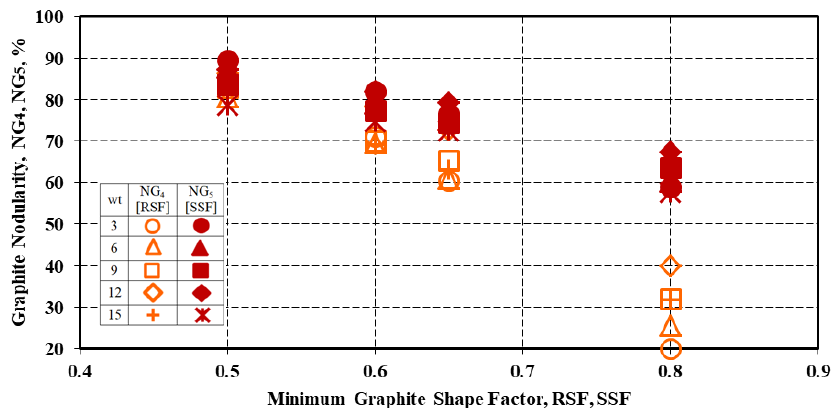
Figure 12. Influence of the minimum imposed Graphite Shape Factors (RSF, SSF) on Graphite. Nodularity NG 4 and NG 5 , as an influence of the wedge casting wall thickness.